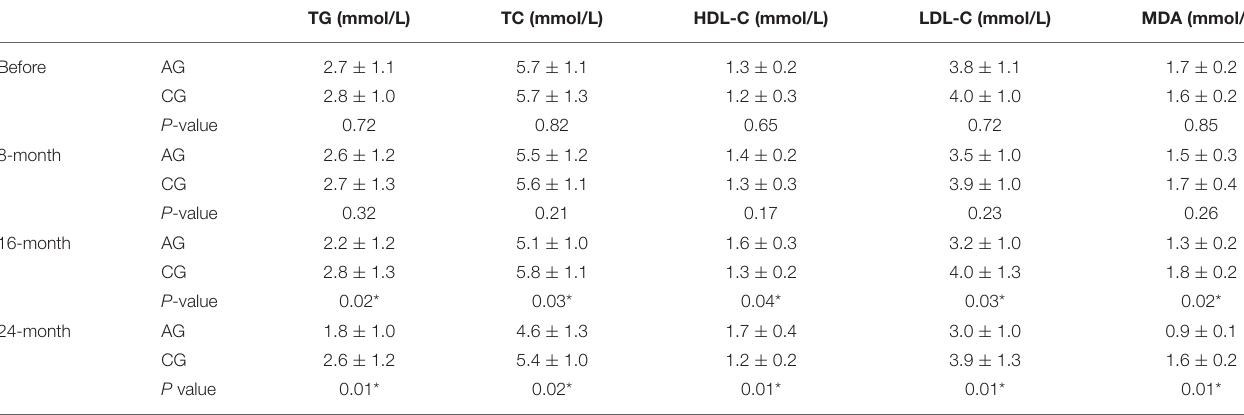
TABLE 2 | Comparison of lipid pattern in osteosarcoma patients before and after therapy.